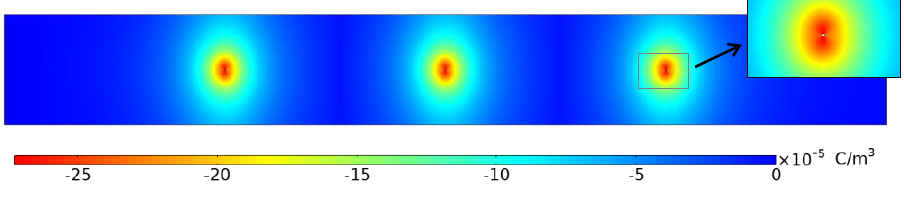
Figure 15. Space charge density contours in the ESS.